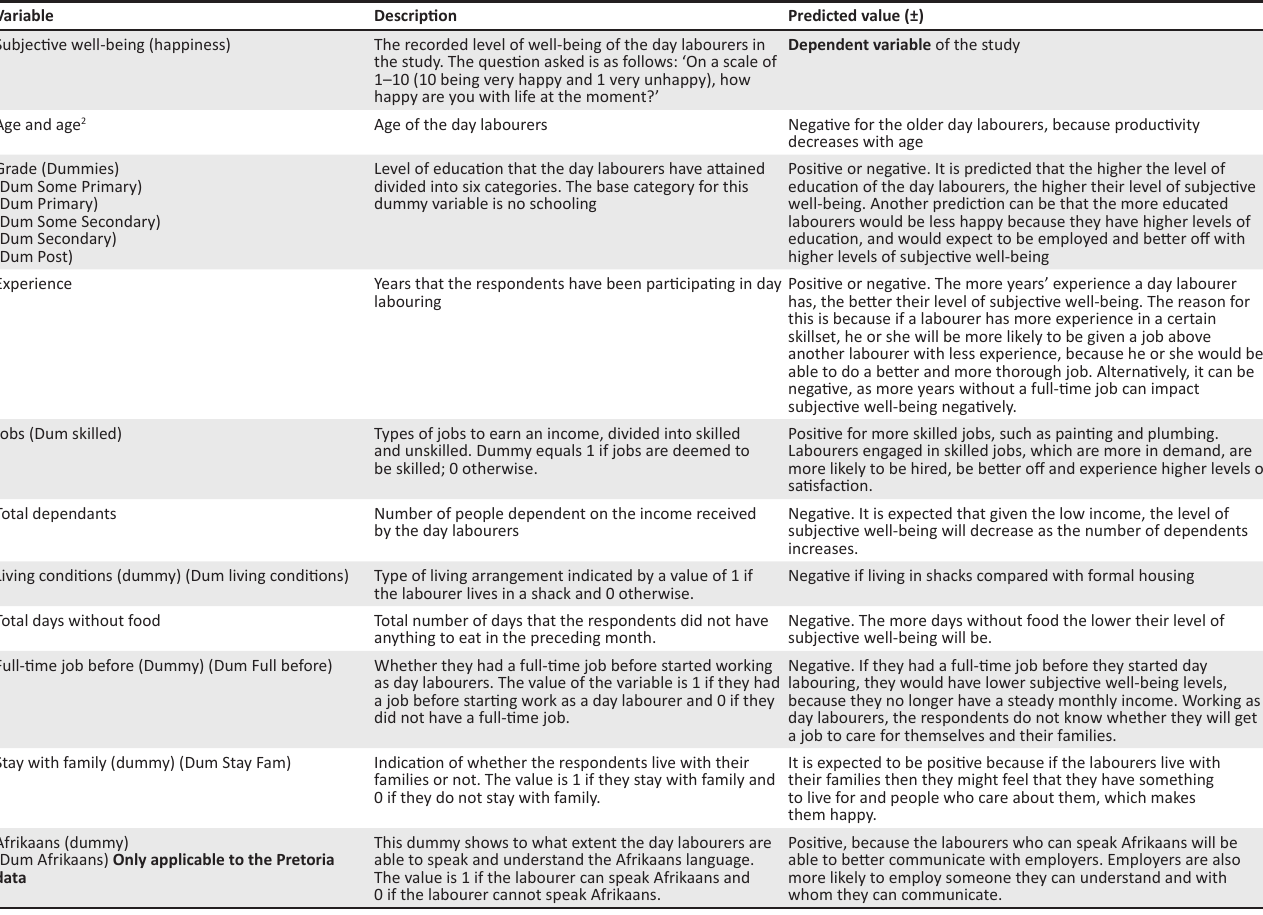
TABLE 3 : Description of the variables used for the Pretoria and Windhoek analysis.